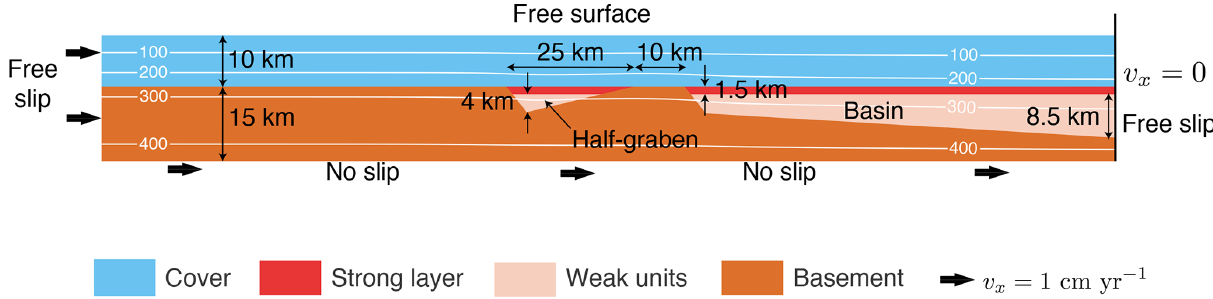
Figure 2. Reference model configuration. The white contours show isotherms and the labels are the corresponding temperatures in ◦